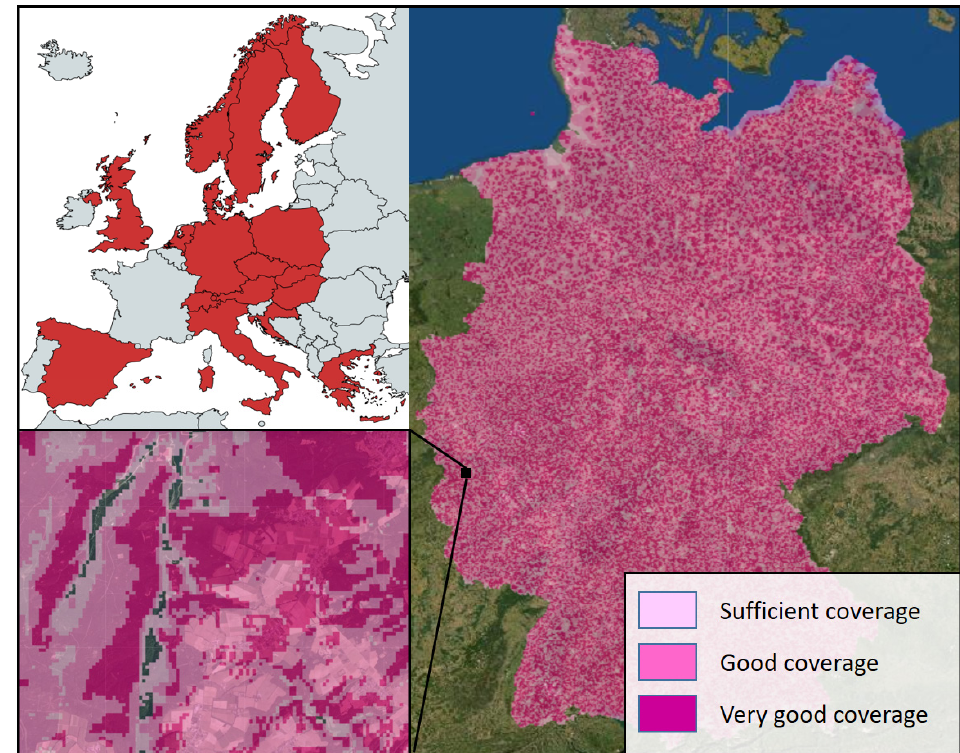
Figure 6. European countries where NB-IoT services are offered ( upper left ), NB-IoT coverage for Germany provided by Deutsche Telekom ( right ), and a large-scale detailed map indicating local NB-IoT gaps in deep valleys in a rural Eifel region in Germany ( lower left ). The NB-IoT coverage maps are based on available interactive maps [55].